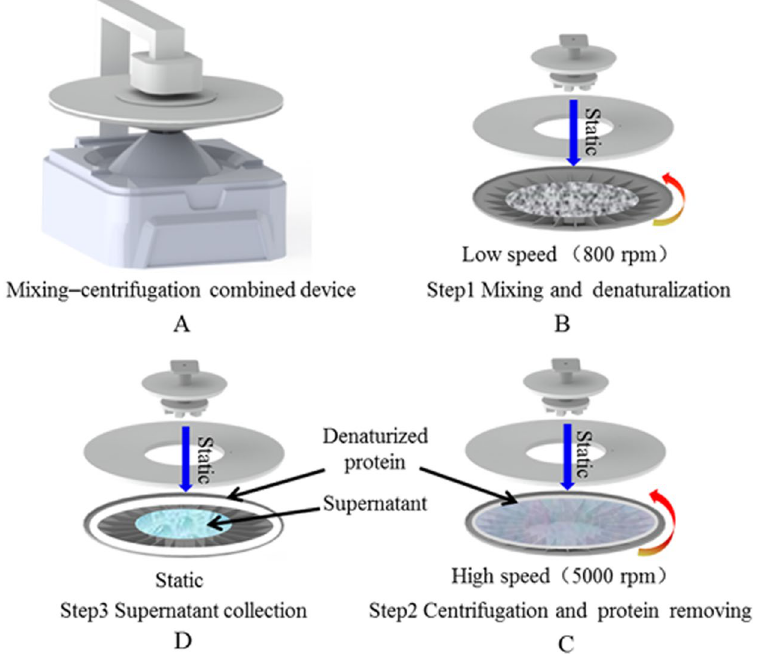
Figure 5. Schematic diagram for mixing–centrifugation device ( A ) and the working process. At low speed ( B , Step 1), the milk sample was mixed with a chemical reagent, and the protein was denaturalized. At high speed ( C , Step 2), the denaturalized protein was thrown away to the edge of the rotor body by centrifugal force. When the rotor stopped ( D , Step 3), the supernatant aggregated to the center of the inverted-shaped rotor body by gravitational force. To aid rapid prototyping and redesign, 3D printing was